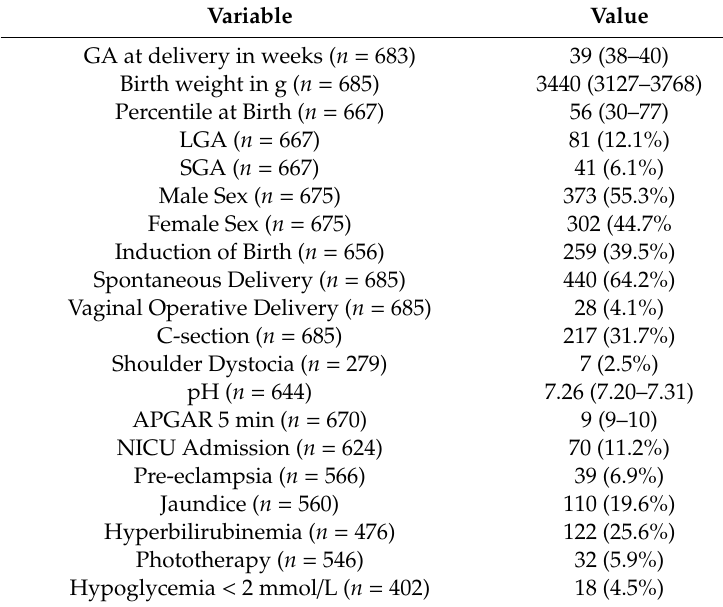
Table 2. Perinatal outcome of 685 mother–infant